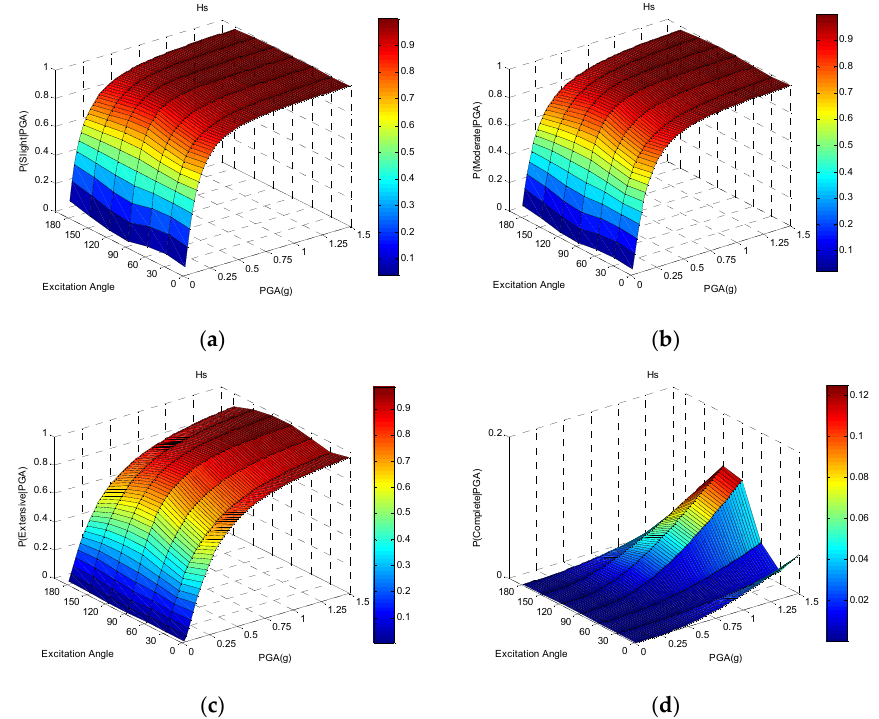
Figure A3. Seismic fragility surfaces of Hs subjected to different excitation angles in the ( a ) slight; ( b ) moderate; ( c ) extensive; and ( d ) complete limit states.